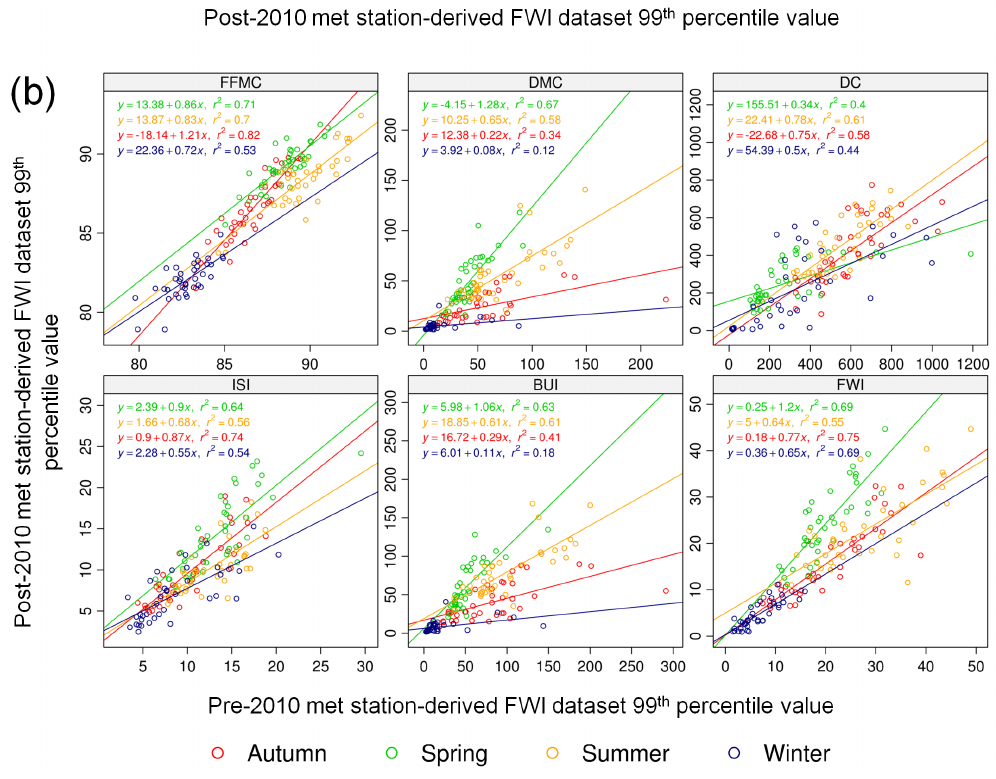
Figure 3. Comparison of the 99th percentile values of the six FWI System components by season, derived (a) from meteorological station data and NWP data from grid cells geographically intersected by these stations, for the 2010–2013 period, and (b) from meteorological station data for the pre- and post-2010 periods for the same stations, with OLS linear regression fits. Data in (a) indicate that extreme values of the FWI components calculated from the NWP-derived FWI data are similar to those calculated from meteorological station data during spring, summer and autumn. (b) shows that while there is some variation in the extreme FWI component values observed between 2010 and 2013 and the pre-2010 data (each met station used in this study has 13–44 years of data, including the years 2010–2013), the data from spring, summer and to a lesser extent autumn from 2010–2013 are broadly representative of longer-term extremes. Accordingly, we conclude that a robust FWI climatology can be constructed from the NWP-derived FWI data set for these seasons, despite its limited